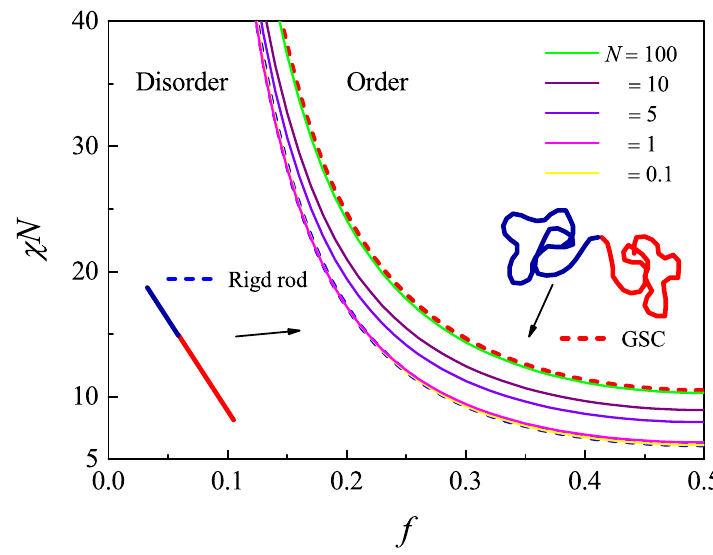
Figure 3. Spinodal lines for a worm-like diblock copolymer melt for various chain flexibilities, L / a = 0.1, 1, 5, 10 and 100, are shown. The curves are within the region bounded by an upper solid red curve and a lower dashed blue curve, produced from the analytic expressions for the structure factors of a Gaussian-chain model and a rigid-rod model,